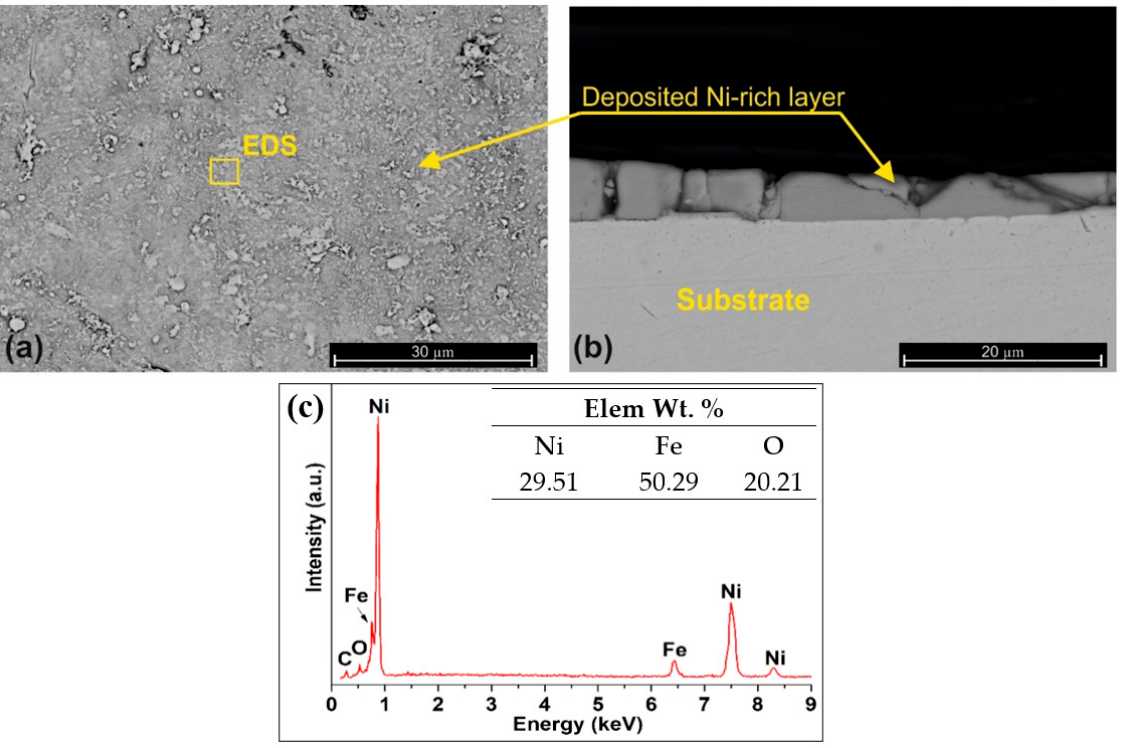
Figure 4. SEM surface ( a ) and cross-section ( b ) of the laser-processed sample at different magnifications; ( c ) EDS analysis of the sample surface.